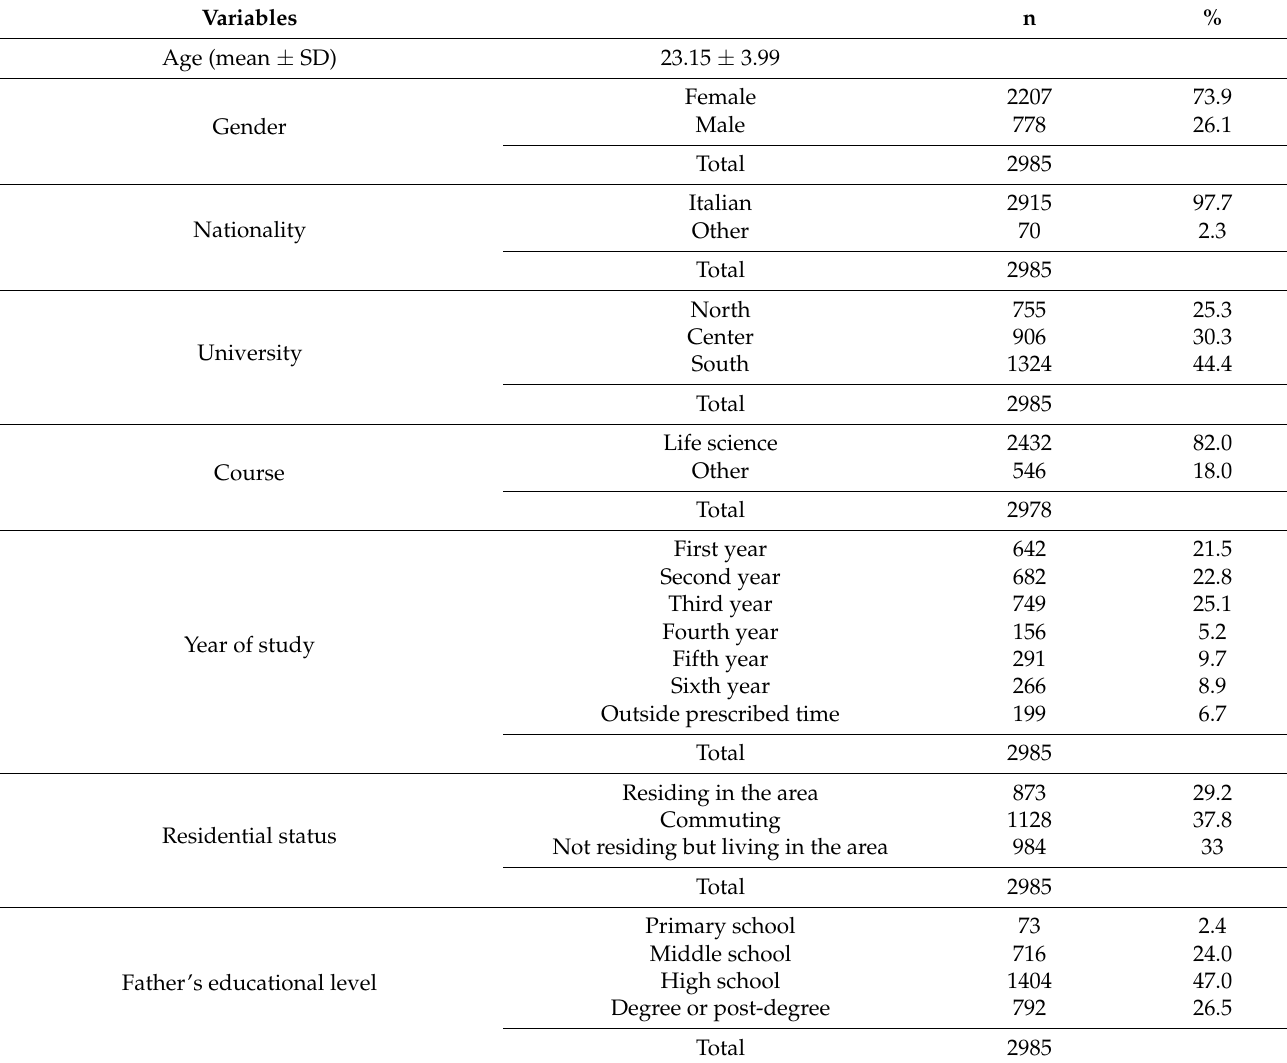
Table 1. Characteristics of the sample and answers related to tattooing and body piercing (n = 2985). Variables n % Age (mean ± SD) 23.15 ±